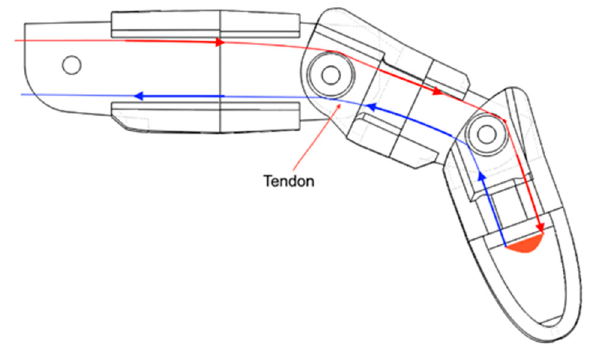
Figure 4. Tendon flexion mechanism.